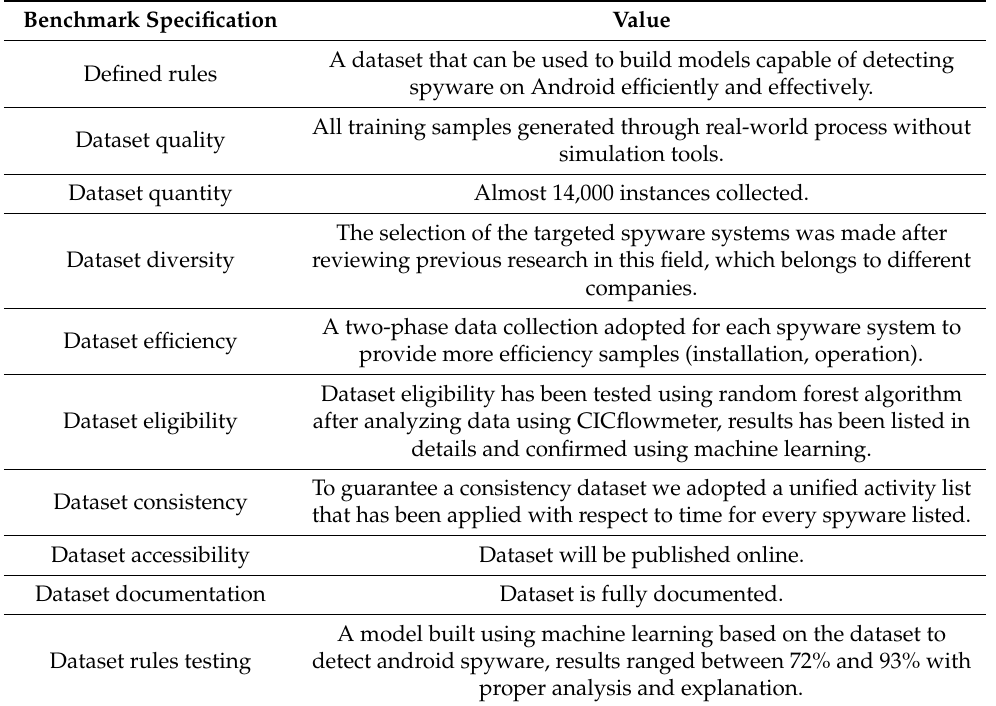
Table 9. Dataset benchmark